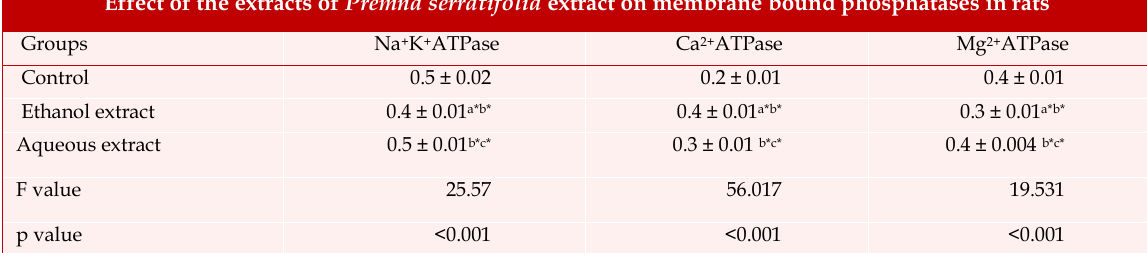
Effect of the extracts of Premna serratifolia extract on membrane bound phosphatases in rats Groups